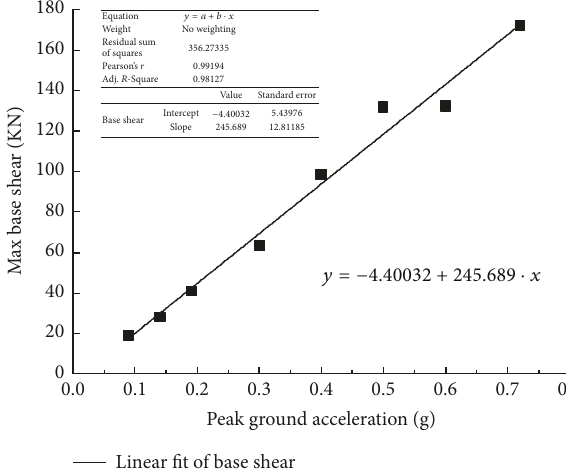
Figure 20: The relationship between max base shear and PGA under Wolong record